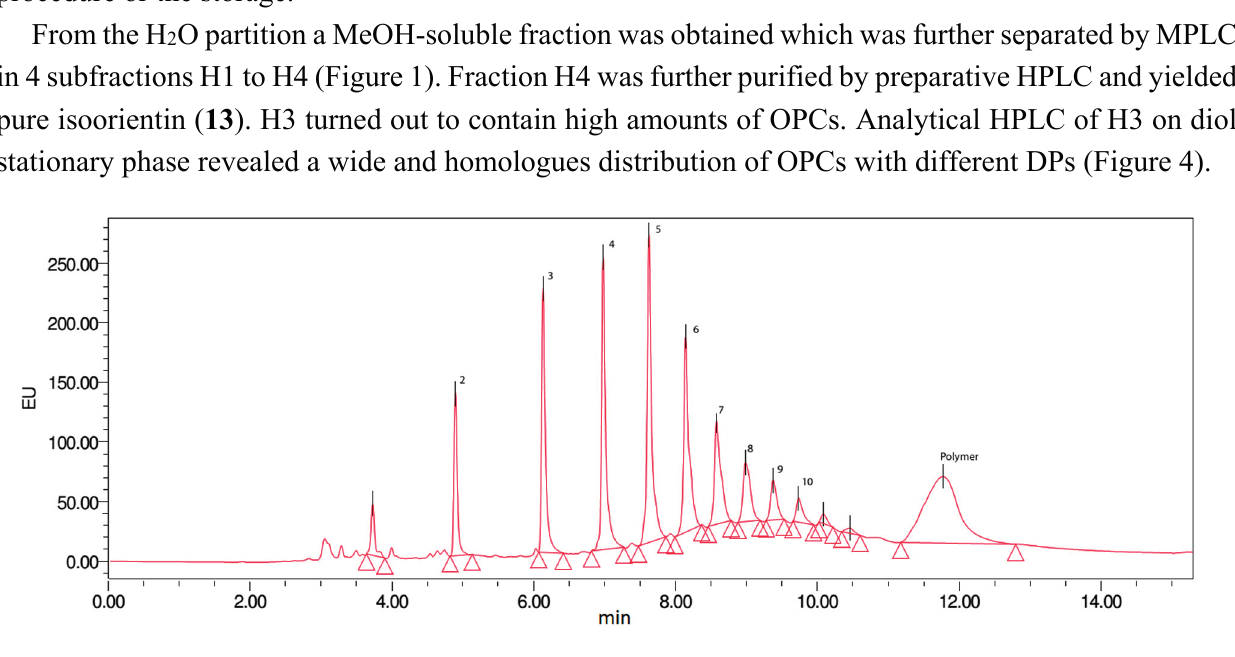
Figure 4. UHPLC of the OPC-enriched fraction H3. Numbers indicate the degree of polymerization of the respective OPC